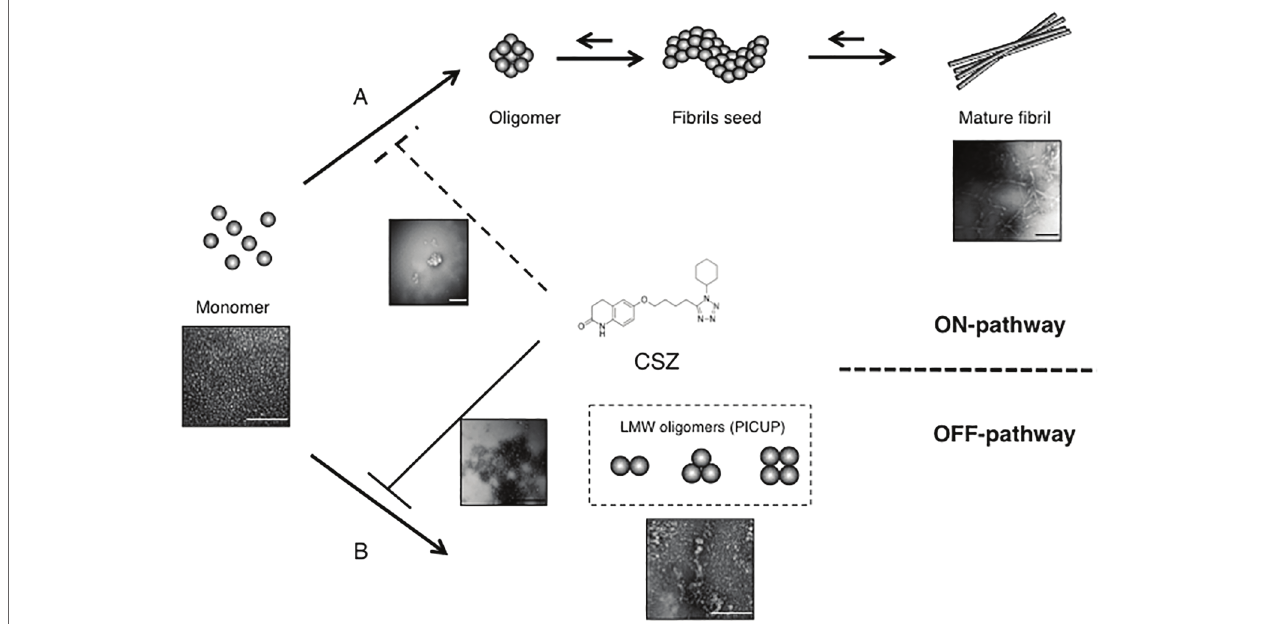
FIGURE 2 | Inhibitory effects of CSZ on A β aggregation. The A β monomer may aggregate to produce toxic intermediate aggregates, such as soluble oligomers, and finally mature fibrils. CSZ inhibits ON-pathway formation of A β fibrils concurrently with strong prevention of OFF-pathway A β oligomers (scale bars = 100 nm). This research was originally published in Neurosci. Lett. (Shozawa et al.,